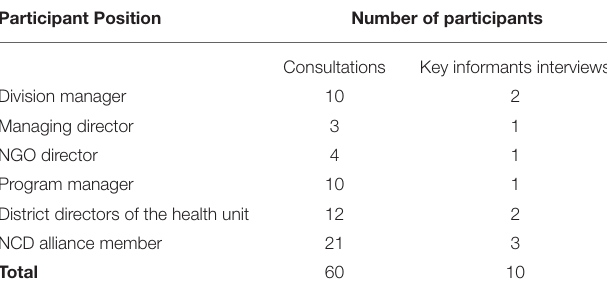
TABLE 1 | Study participants in one-on-one consultations and key informants interviews. Participant Position